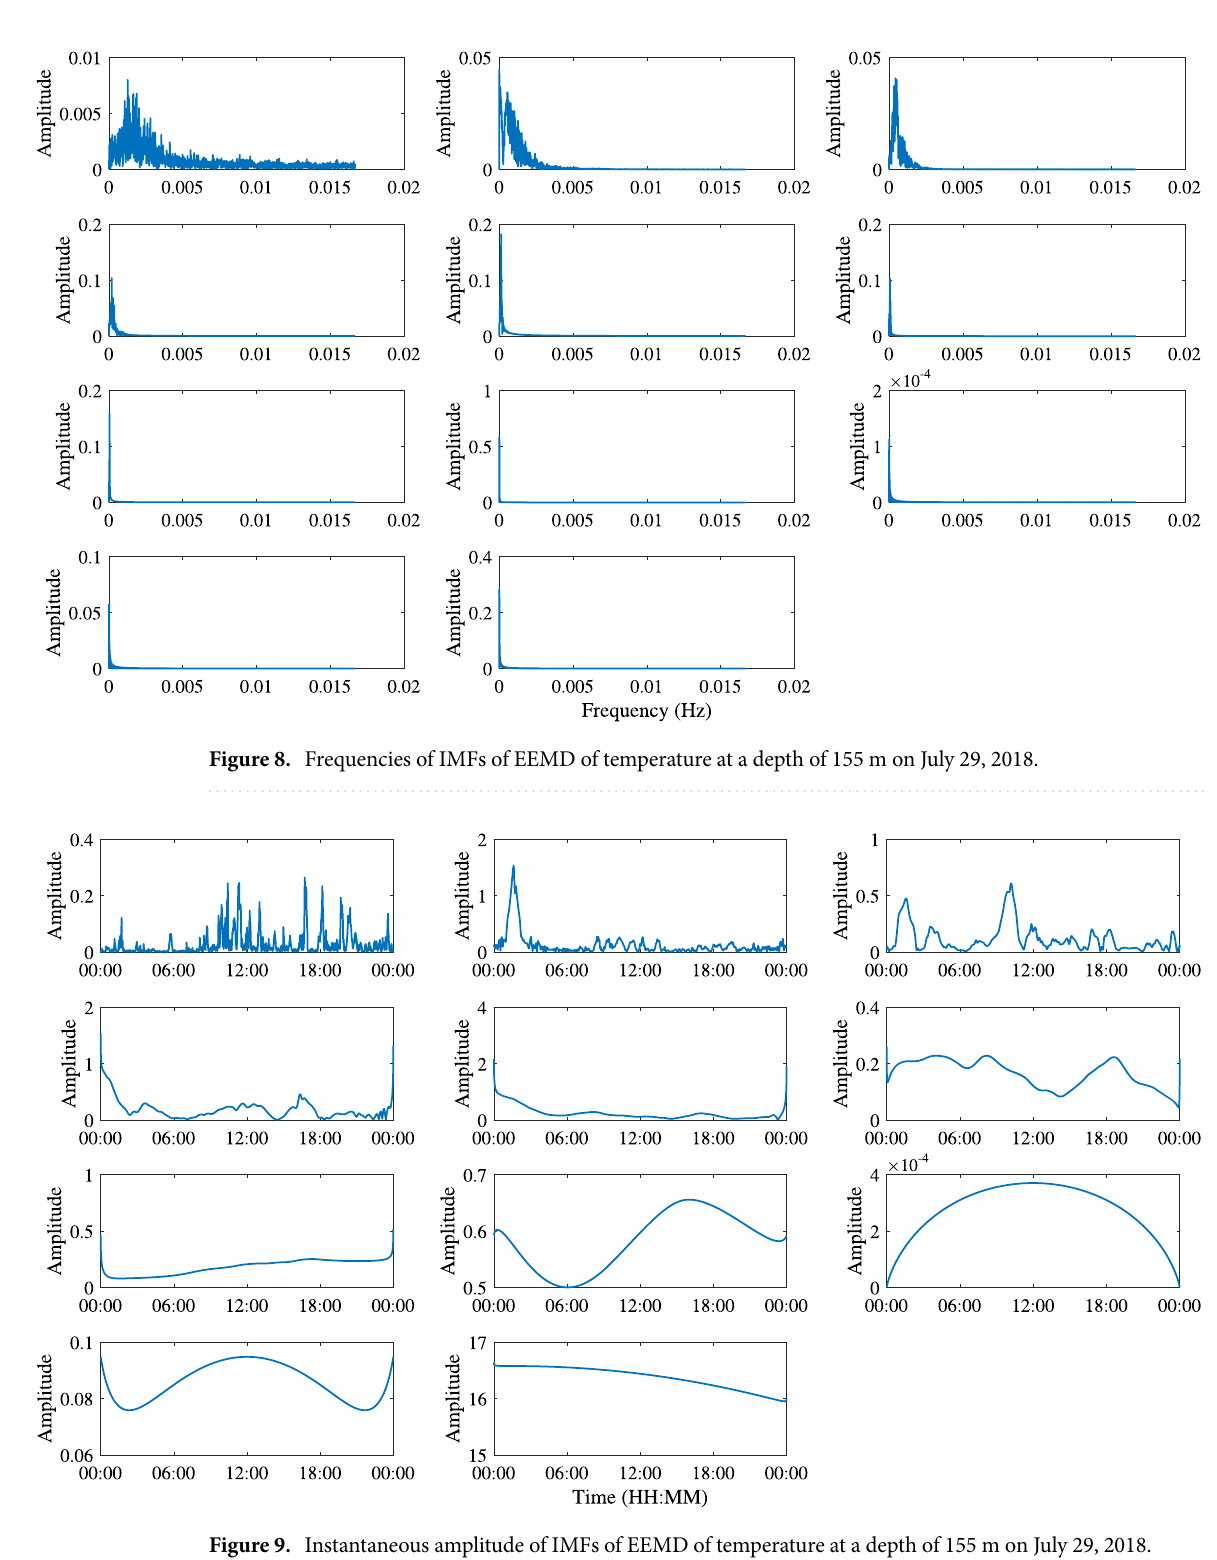
Figure 9. Instantaneous amplitude of IMFs of EEMD of temperature at a depth of 155 m on July 29,